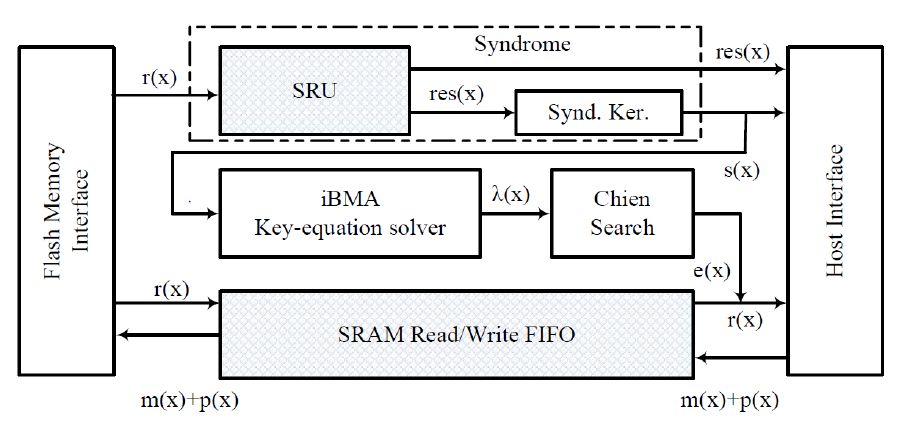
Figure 2. Hybrid BCH decoder block